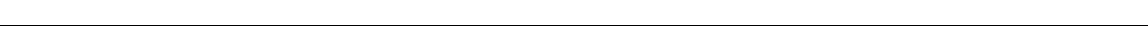
Fig. 6 Increase of injury-activated glial cell numbers in the wound bed boosts myo fi broblast differentiation through TGF- β activation. a Scheme of the experimental strategy for Plp-CreER T2 -mediated glial cell expansion in our murine wound healing model through Pten cKO. b Immunolabelling of pAKT (green) and Sox10 (red) in NB of skin wound sections at D7 shows a signi fi cant increase in PI3K signalling upon Pten cKO. c Immunolabelling of p75 (green) in Ctrl and Pten cKO skin wound sections at D14. d , e Quanti fi cation of p75 + and tdTomato + cells per mm 2 of granulation tissue shows a signi fi cant increase in p75 + cells at D7 and D14 and traced cells at D7 upon Pten cKO. Quanti fi cation of D7 wound sections of the percentage of f wound closure, g area of HPE, h wound contraction, i re-epithelialisation reveals no difference in these parameters. j Immunolabelling of α -SMA (green) in Ctrl and Pten cKO skin wound sections at D7. k , l Quanti fi cation of the percentage of α -SMA + area of the granulation tissue at D7 and of the percentage of pSMAD2 + cells per α -SMA + area of the granulation tissue of skin wounds at D5 shows increase of both myo fi broblast-occupied area and canonical TGF- β signalling in Pten cKO skin wounds. Note that control data sets in Fig. 6k and Fig. 5i are the same because the experiments were performed at the same time. Data are represented as mean ± SEM of N = 2, n = 8 (Ctrl D7), N = 2, n = 8 (Ctrl D14); N = 3, n = 10 ( Pten cKO D7), N = 2, n = 8 ( Pten cKO D14) ( d ); N = 4, n = 7 (Ctrl), N = 2, n = 6 ( Pten cKO) ( e ); N = 4, n = 16 (Ctrl), N = 5, n = 20 ( Pten cKO) ( f ); N = 3, n = 12 (Ctrl), N = 4, n = 16 ( Pten cKO) ( g ); N = 4, n = 16 (Ctrl), N